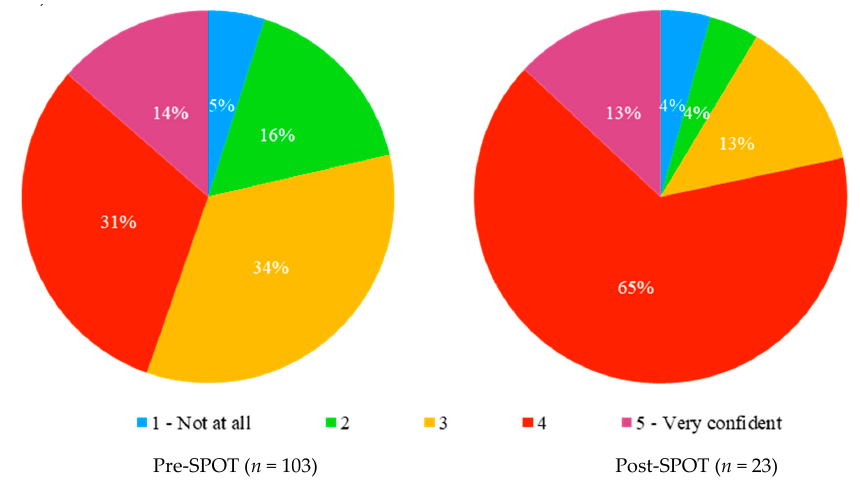
Figure 1. Users’ self-reported confidence with opioid conversions, before and after the SPOT study.